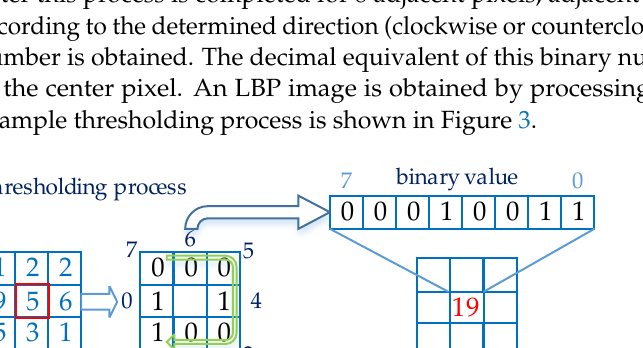
Figure 3. Application of the Local Binary Patterns method.